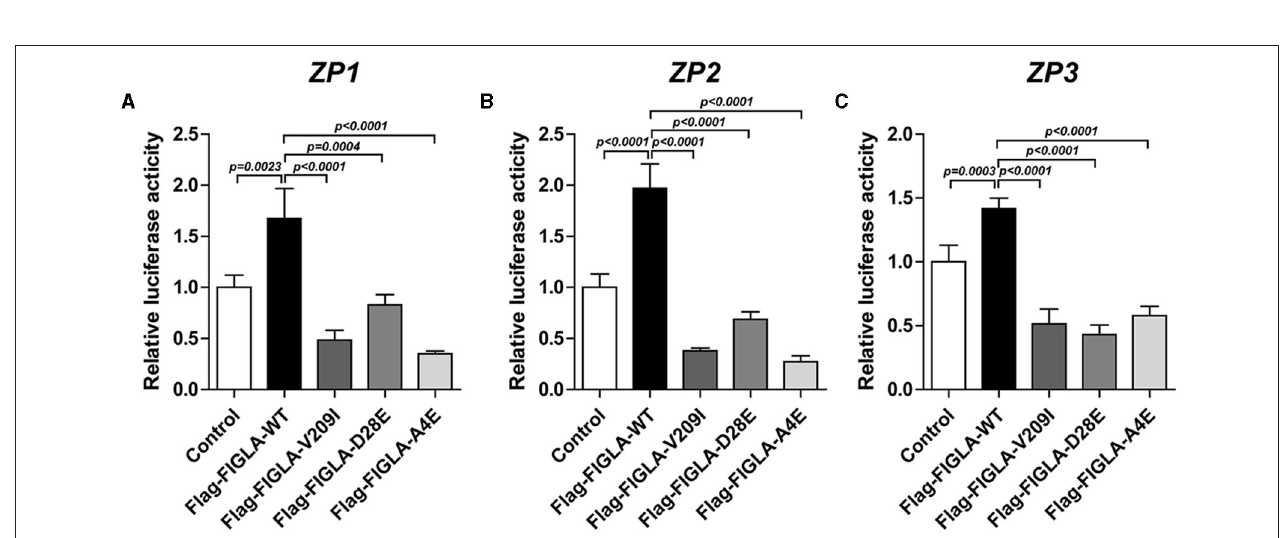
FIGURE 3 | FIGLA mutation impairs the transcriptional activity of ZP1 , ZP2 , and ZP3 . HEK293 cells were transfected with Flag-FIGLA-WT, Flag-FIGLA-V209I, Flag-FIGLA-D28E, or Flag-FIGLA-A4E. The transcriptional activity of ZP1 (A) , ZP2 (B) , and ZP3 (C) promoter fragments was detected by a luciferase reporter assay. Results were mean ± SD for three individual experiments which, for each condition, were performed in triplicate.